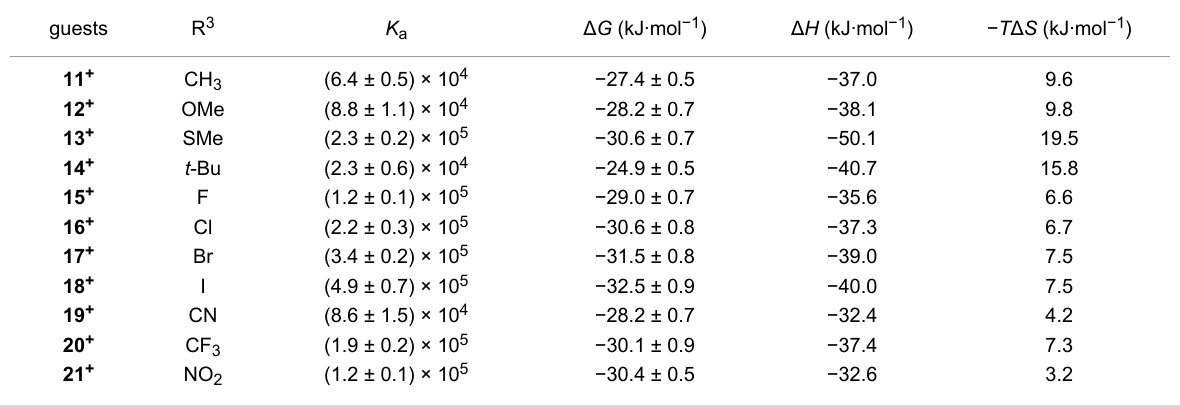
Table 2: Association constants (M − 1 ) and other thermodynamic parameters of ZB4 with guests 11 + – 21 + as determined by ITC titrations in a 1:1 mix- ture of 1,2-dichloroethane and MeCN at 298 K.